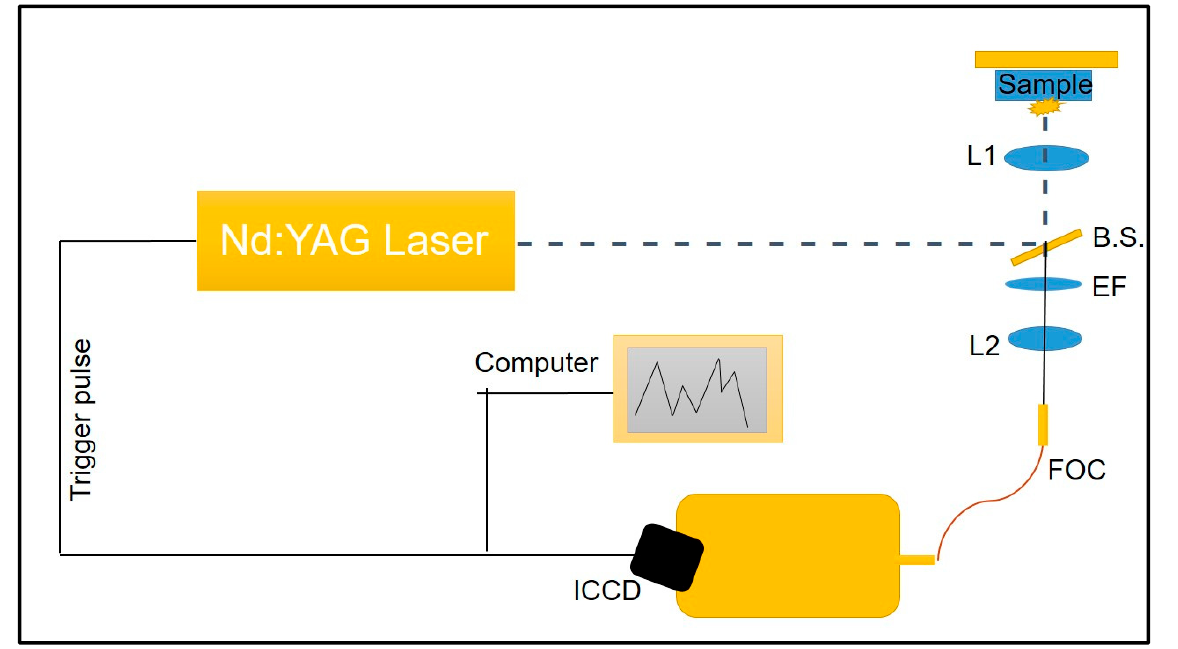
Figure 2. Experimental setup. Reproduced from [28], with the permission of SPIE.